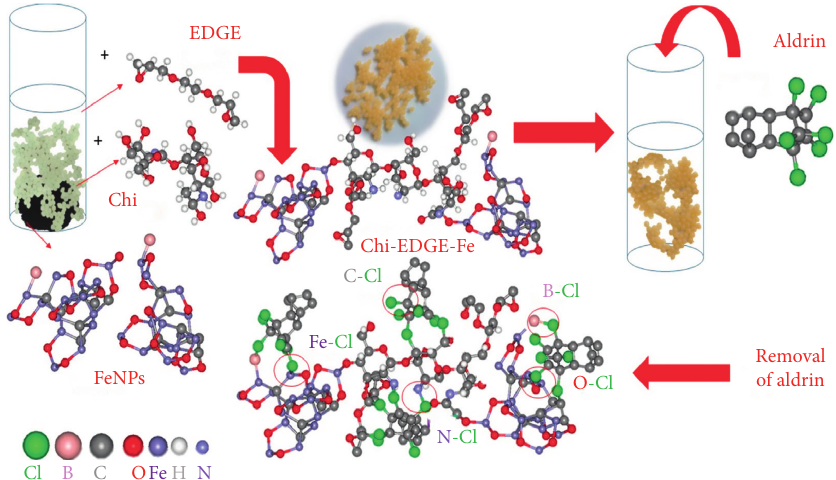
Figure 8: Proposal mechanism between Chi-EGDE-Fe and the